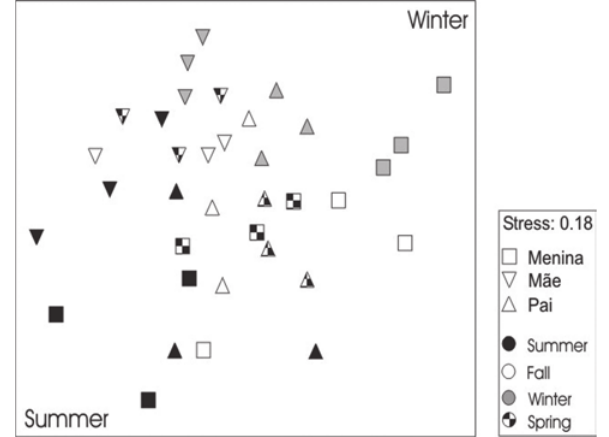
Fig. 3. Nonmetric multidimensional scale (nMDS) analysis of individual samples from Menina, Mãe and Pai Islands indi- cating a Summer – Winter seasonal gradient. Table 3. Results of the two-way crossed analysis of